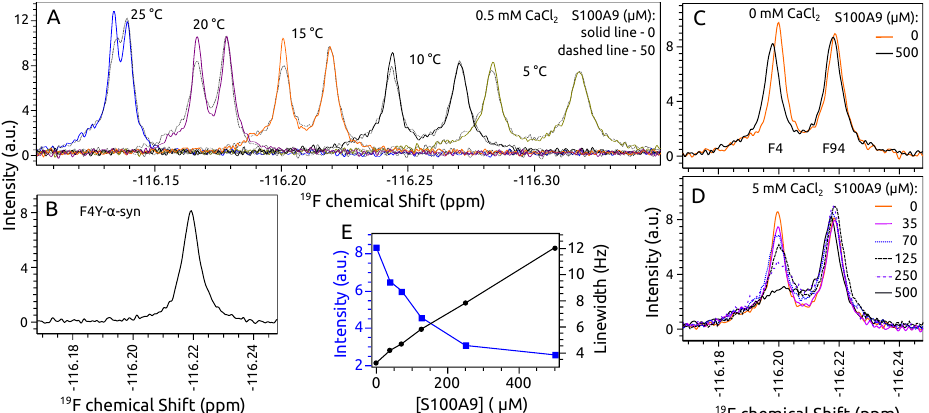
Figure 1. One-dimensional (1D) 19 F NMR spectra. of 4-fluoro-Phe4 (F4 peak) and 4-fluoro-Phe94 (F94 peak) labeled α -syn: ( A ) spectra at different temperatures from 25 to 5 ◦ C in absence (solid line) and presence (dotted line) of 50µM S100A9, ( B ) F4Y α -syn mutant, ( C ) spectra in absence (orange spectrum) and presence (black) of 500µM S100A9 without addition of calcium chloride, ( D ) spectra in the presence of different concentrations of S100A9 and 5mM CaCl 2 . ( E ) The line width and intensity change of α -syn F4 peak at different concentrations of S100A9. Protein solution: 50µM α -syn, 0µM, 35µM, 50µM, 70µM, 125µM, 250µM, 500µM S100A9, 25mM HEPES, 100mM NaCl, 5mM DTT, 0mM or 5mM CaCl 2 , 5% D 2 O, 0.02% sodium azide, pH 7.40. Spectra in panels B–D were recorded at 15 ◦